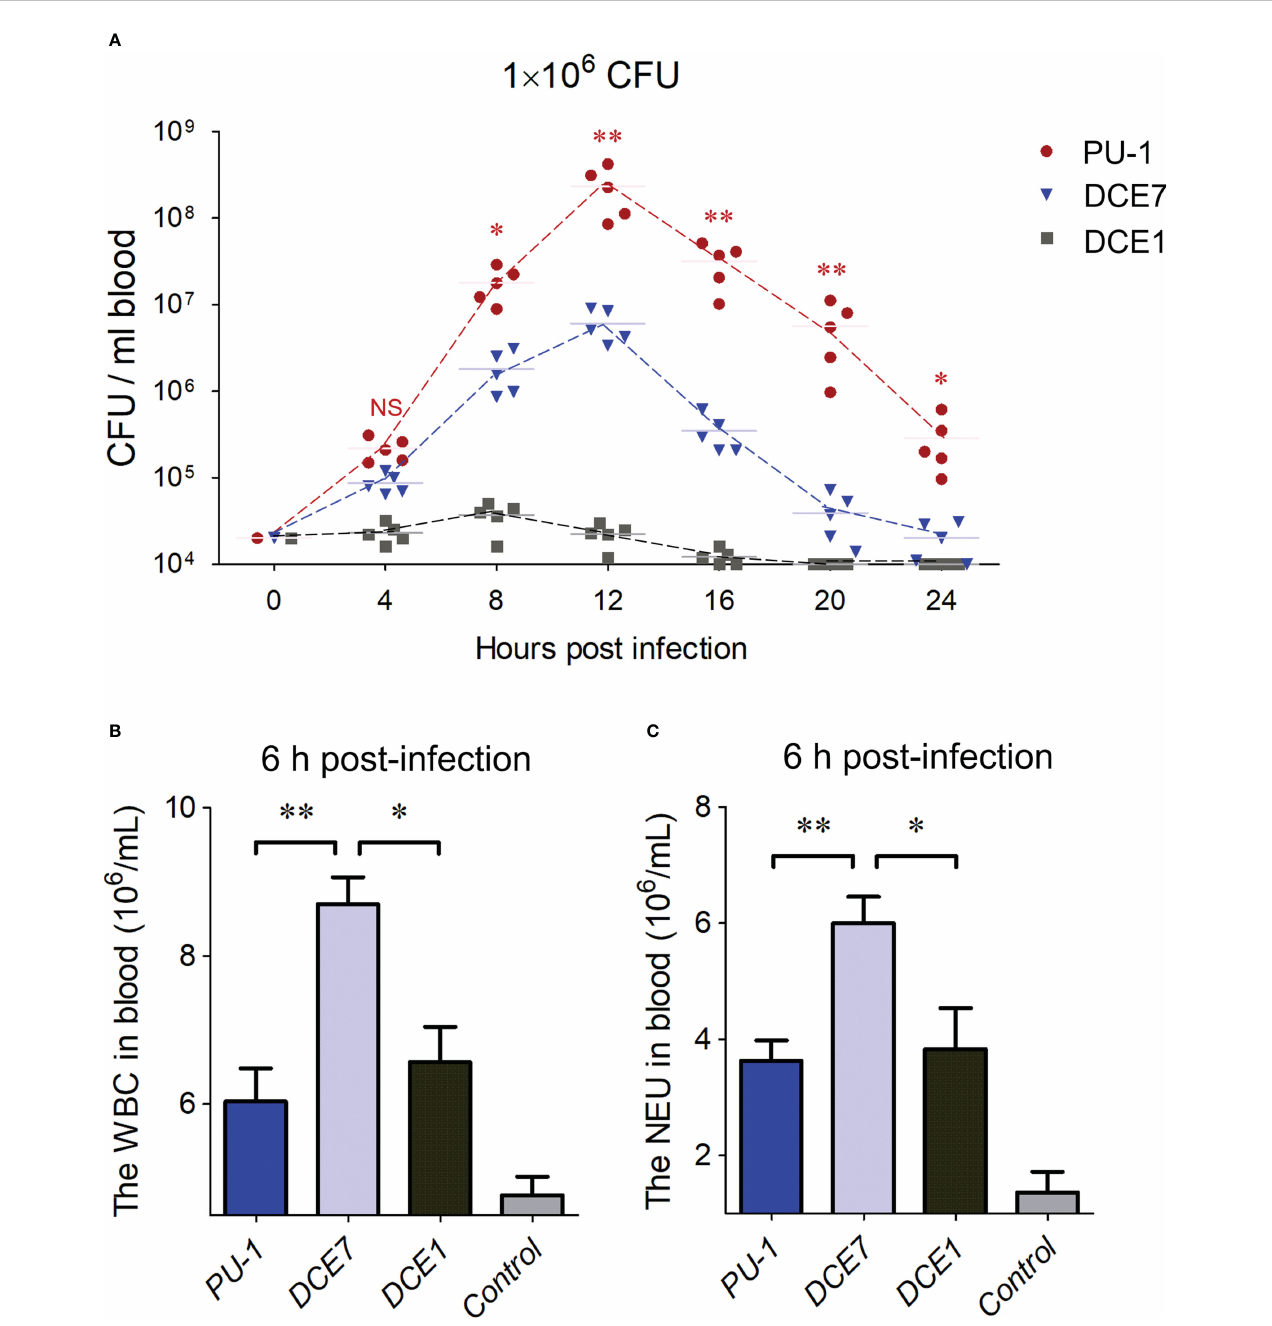
FIGURE 1 ExPEC strain PU-1 caused a heavy bacterial load in infected mouse blood. (A) The curves showed the bacterial loads in bloods from the mice challenged with different E. coli strains until 24 h post infection. The ExPEC strains DCE7 and DCE1 were used as controls here, respectively. Statistical signi fi cance of PU-1 infection group was determined by a one-way ANOVA test based on comparisons with the DCE7 infection group (**P < 0.01, *P < 0.05). (B, C) Blood routine testing detected the white blood cell (WBC) and neutrophil cell (NEU) counts of peripheral blood from the mice infected with indicated ExPEC strains at the 6 h post-infection. Statistical signi fi cance was determined by a one-way ANOVA test based on comparisons with the wild-type group (**P < 0.01, *P < 0.05). NS, no signi fi